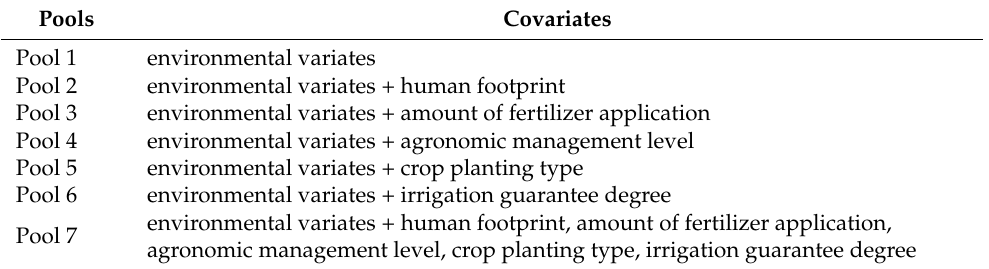
Table 2. Pools with different covariates. (Environmental covariates consisted of elevation, aspect, slope, landform class, average precipitation, average temperature, lithological unit, average NDVI, sedimentary deposit thickness, average soil moisture, soil type, water table depth, solar radiation, and surface water